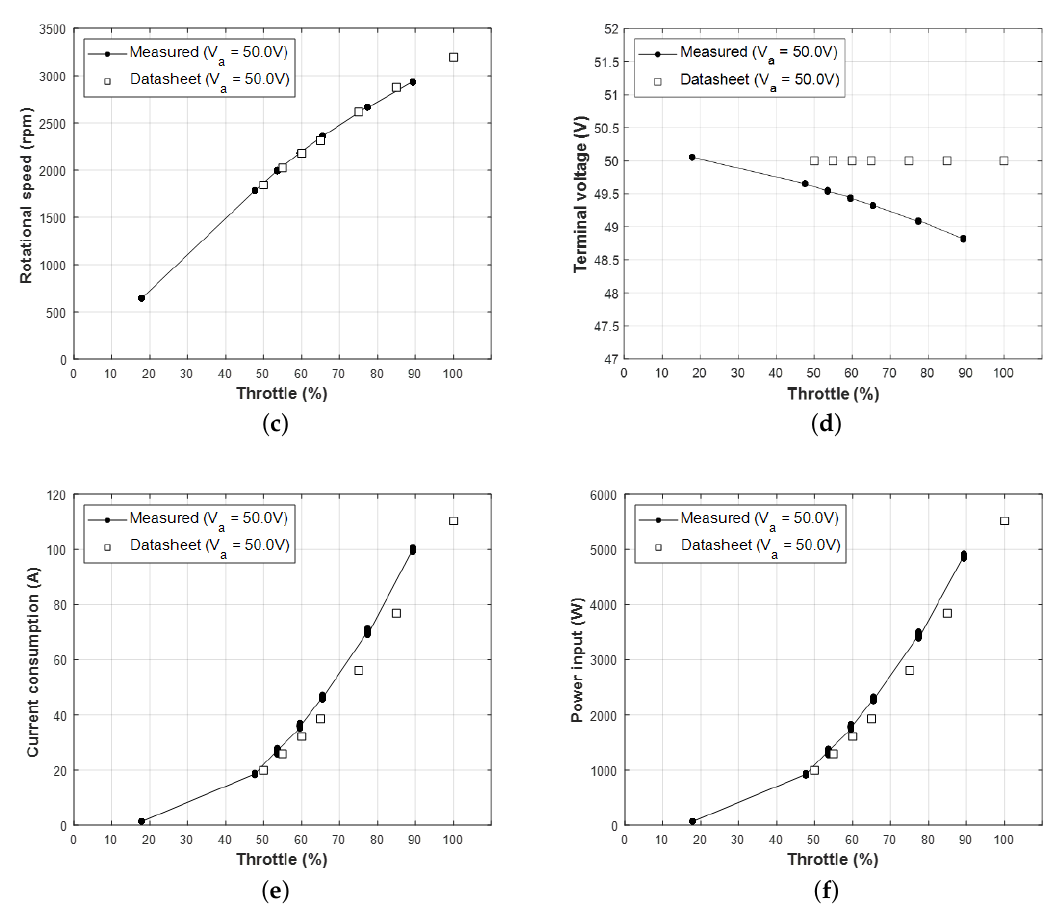
Figure 18. Static thrust test results of sample set 1 (T-motor U15II with T-motor G40x13.1CF) compared with the datasheet: ( a ) Thrust, ( b ) torque, ( c ) rotational speed ( d ) terminal voltage ( e ) current consumption, and ( f ) power input.